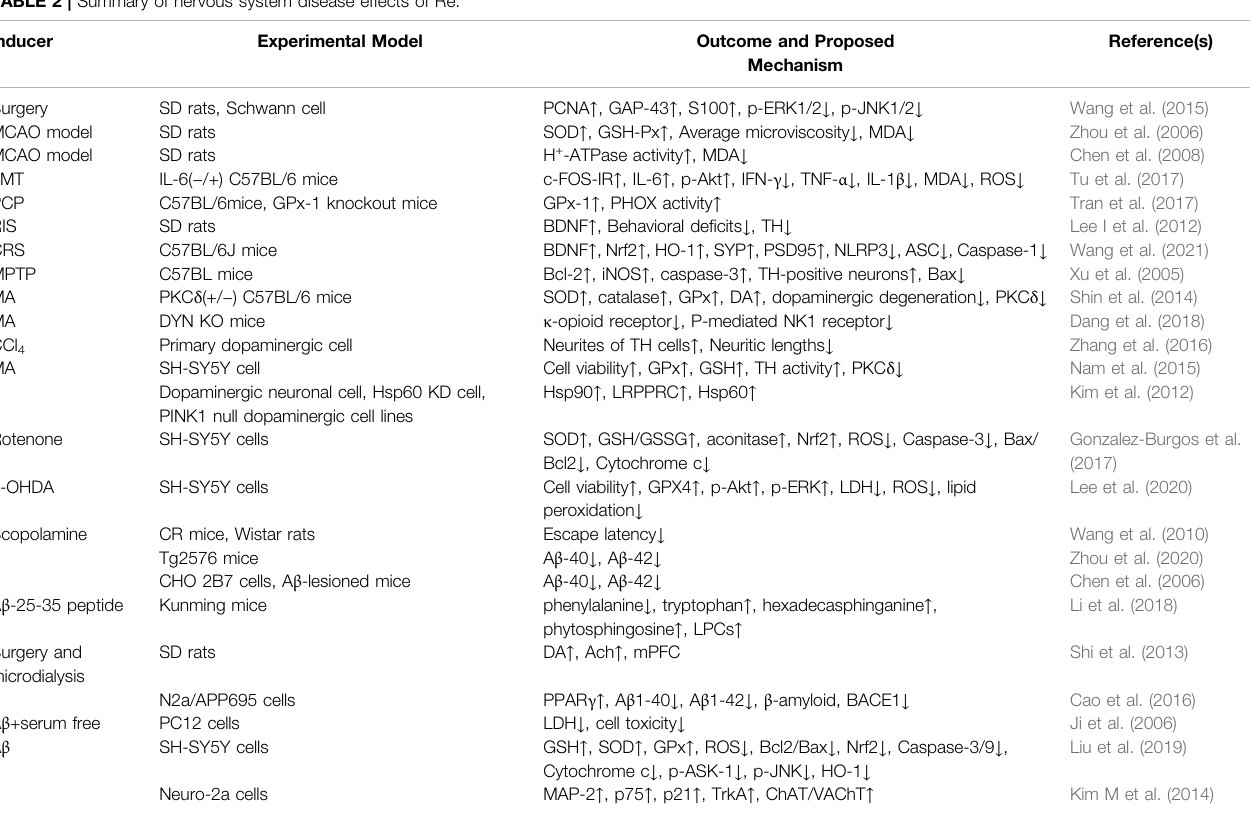
TABLE 2 | Summary of nervous system disease effects of